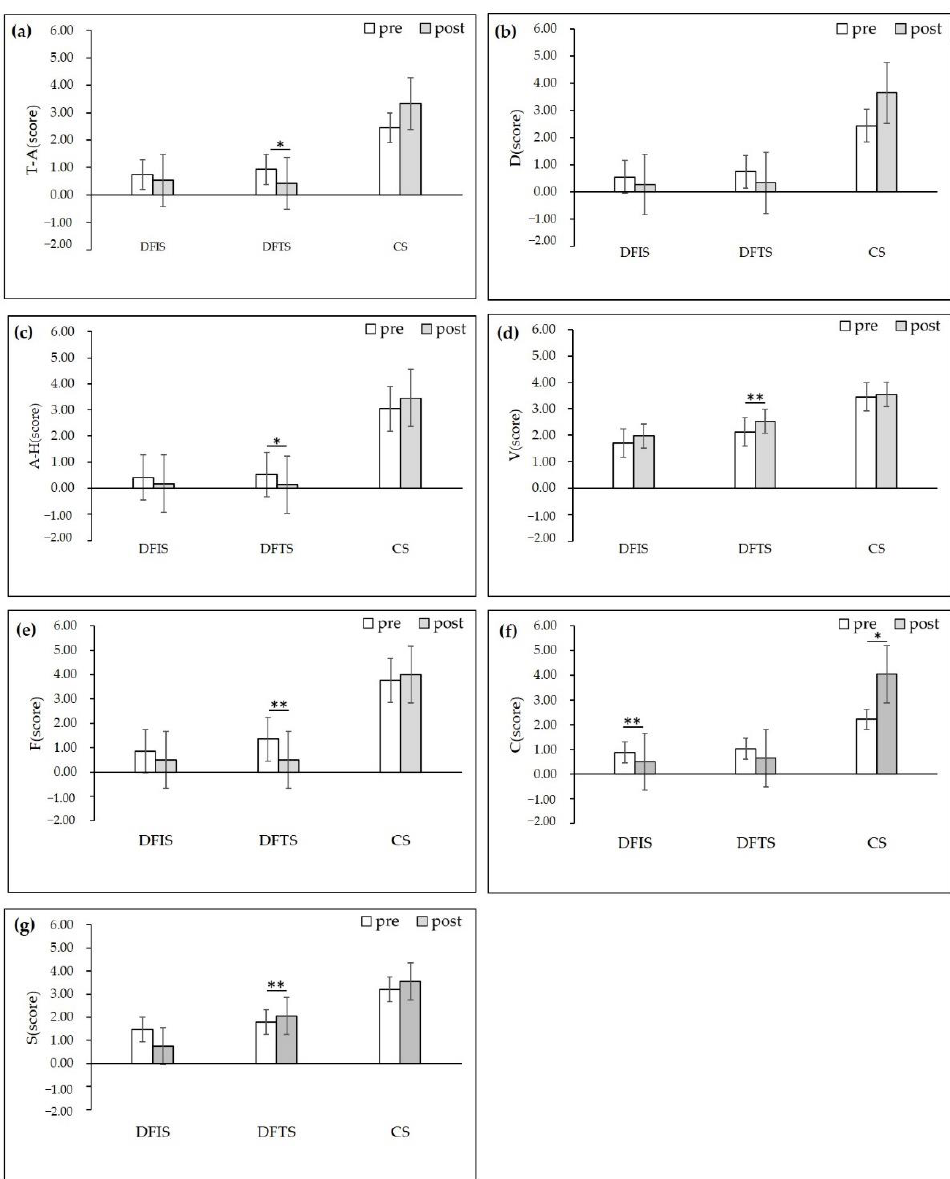
Figure 7. POMS scores before and after the three stimulating environments: ( a ) T-A scores change; T-A: tension-anxiety; ( b ) D scores change; D: depression; ( c ) A-H scores change; A-H: anger-hostility ( d ) V scores change; V: vigor; ( e ) F scores change; F: fatigue; ( f ) C scores change; C: confusion; ( g ) S scores change; S: self-esteem; ( n = 120; mean ± SD; * p < 0.05; ** p < 0.01, verified by Wilcoxon signed-rank test; DFIS: deciduous forest interior setting; DFTS: deciduous forest trail setting; CS: city setting).